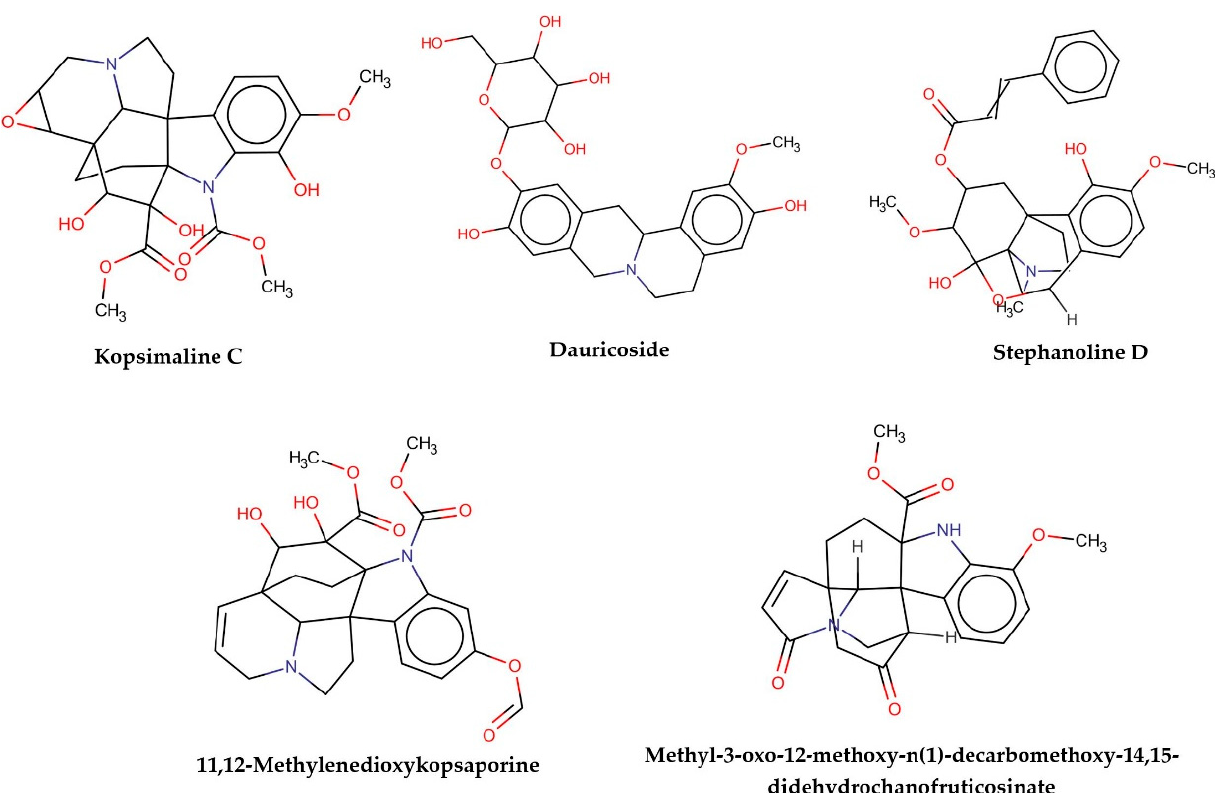
Figure 2. Consensus hits from the structure-based and ligand-based virtual screening.